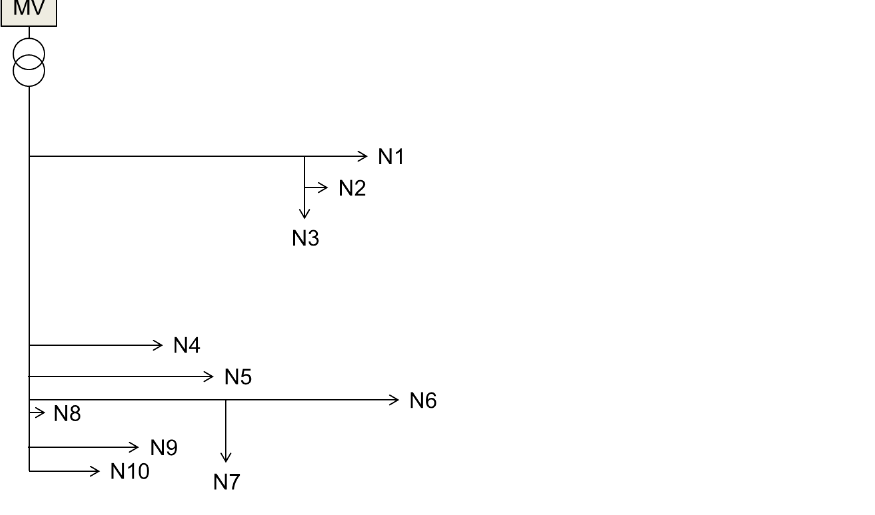
Figure 2. Schematic representation of the ’Merit Order Netzausbau 2030’ (MONA) 21-bus test feeder. The simulation scenario combines distributed generation through photovoltaic (PV) at every household (N1 to N10) together with individual active and reactive loads from the households. For this, load profiles by Tjaden et al. [39] were used that provide three-phase values for active and reactive power at every second. The first ten profiles were utilized. For the PV feed-in, a normalized PV profile [40] was multiplied by a fixed factor for every household (see Table 2) to model different PV sizes. These factors were chosen randomly around an average PV size of 5 kWp for residential PV installations. For all following simulations, the three phases are assumed symmetric; thus, only the results of phase A are presented. Figure 3 shows the load and PV profile at node N10